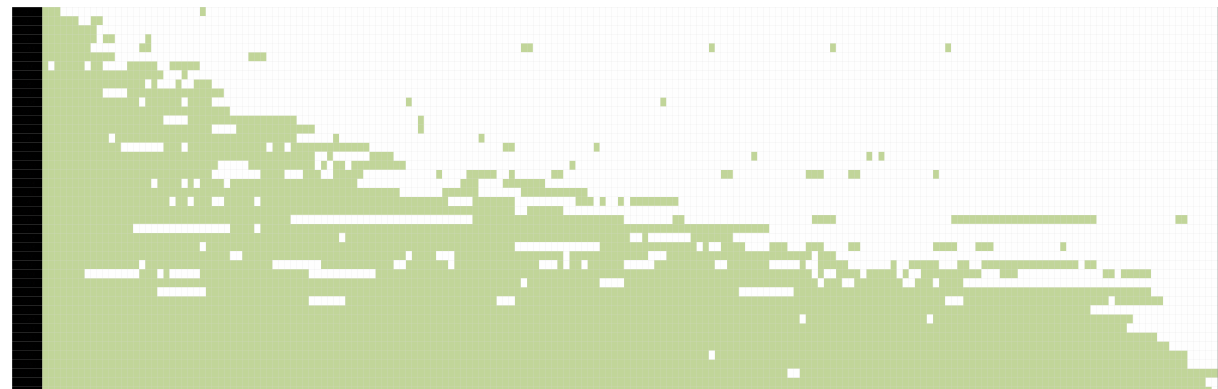
Figure 1. Distribution of days of dietary recording on My Meal Mate for each participant (n=43) over the course of the 6-month My Meal Mate pilot trial. The x-axis is the My Meal Mate ID number that was automatically assigned to the participant and the y-axis is dietary self-monitoring in days. Each green shaded box is a day with ≥ 500 and ≤ 5000 kcal energy recorded on My Meal